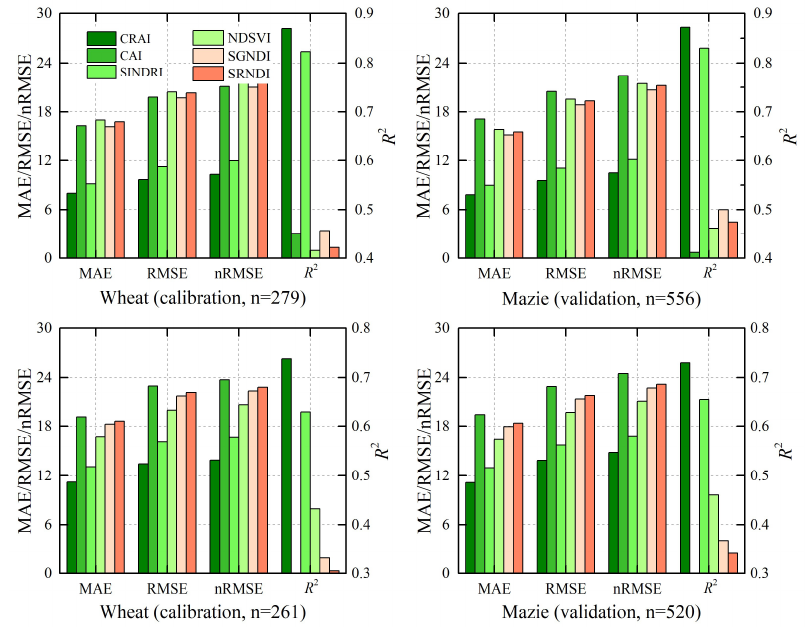
Figure 11. Statistics of regression accuracy (mean absolute error (MAE) (%), root mean square error (RMSE) (%), normalized root mean square error (nRMSE) (%), and coefficient of determination ( R 2 )).